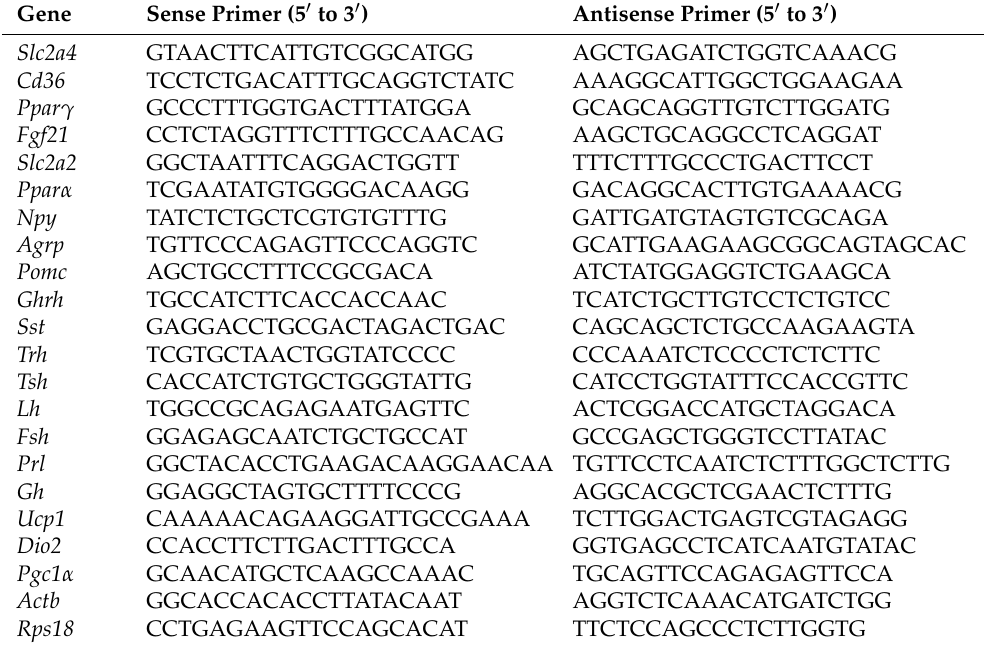
Table 2. Cont. Gene Sense Primer (5 (cid:48) to 3 (cid:48)